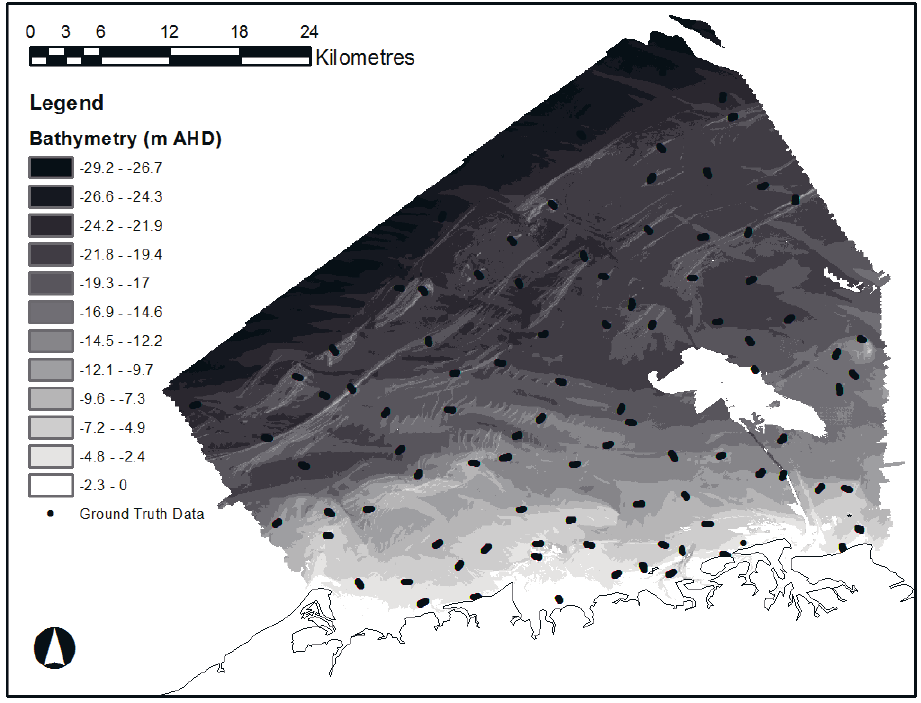
Figure 3. Classified benthic habitat ground truthing transects are distributed randomly across the entire domain to reduce